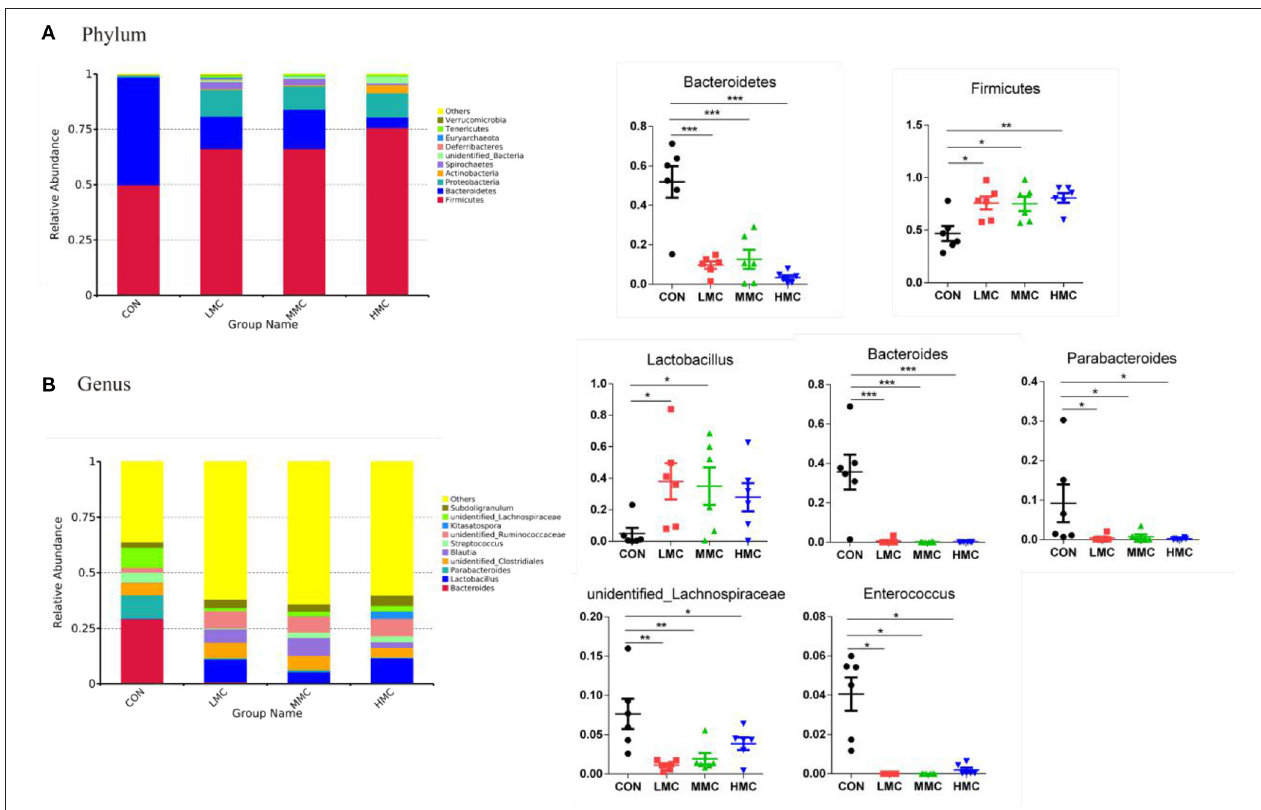
FIGURE 5 | Effects of dietary Moutan cortex radicis on microbial composition at the phylum and genus levels of growing pigs. (A) Relative contribution of the top 10 phylum in each group (left) and the relative abundance of significantly different microorganisms (right); (B) Relative contribution of the top 10 genus in each group (left) and the relative abundance of significantly different microorganisms (right). CON, control group, basal diet without antibiotics; LMC, the control diet + 2,000 mg/kg Moutan cortex radicis ; MMC, the control diet + 4,000 mg/kg Moutan cortex radicis ; HMC, the control diet + 8,000 mg/kg Moutan cortex radicis . Data are expressed as means ± SEM ( n = 6). * P < 0.05, ** P < 0.01, and *** P <